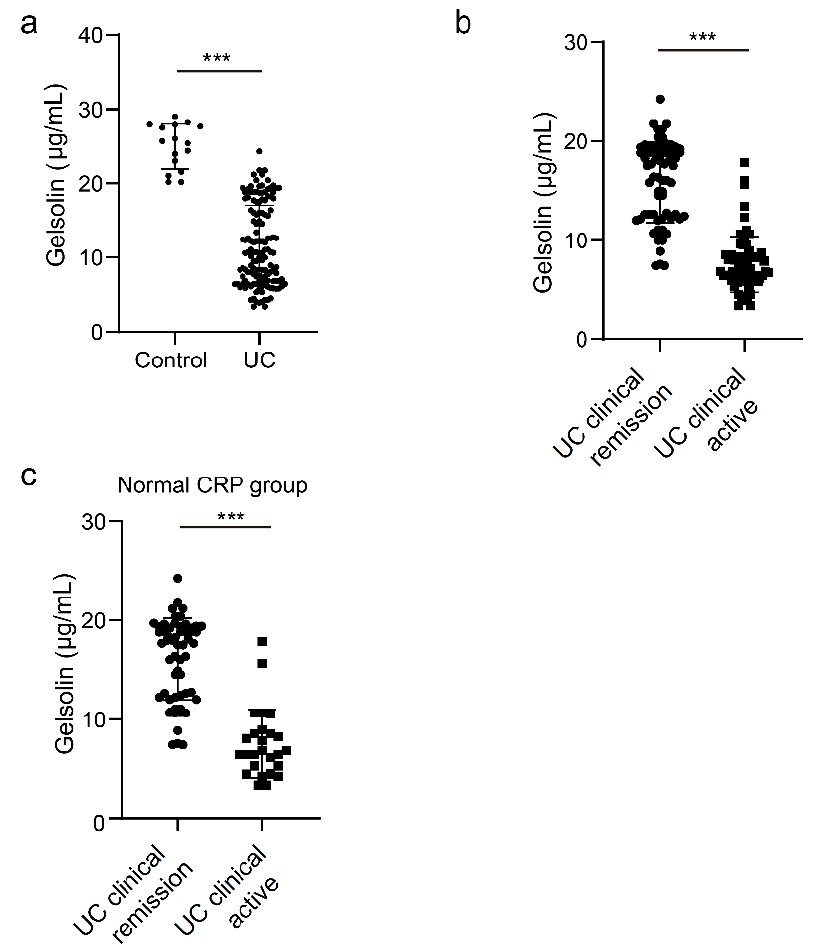
Figure 1. Serum gelsolin (GSN) level decreased in clinically active patients with ulcerative colitis (UC). Serum GSN level was measured in ( a ) 138 patients with UC and 16 healthy subjects (control); ( b ) 68 patients with UC in clinical remission and 70 patients with clinically active UC; and ( c ) 56 patients with UC in clinical remission and 26 patients with clinically active UC and normal C-reactive protein (CRP) level (<0.14 mg/dL). Statistical significance was defined as p < 0.05 (*** p < 0.001) using Mann–Whitney U-test.